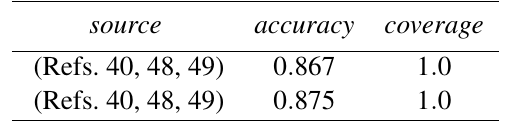
Table 2. Best results for Australian credit by granular approach